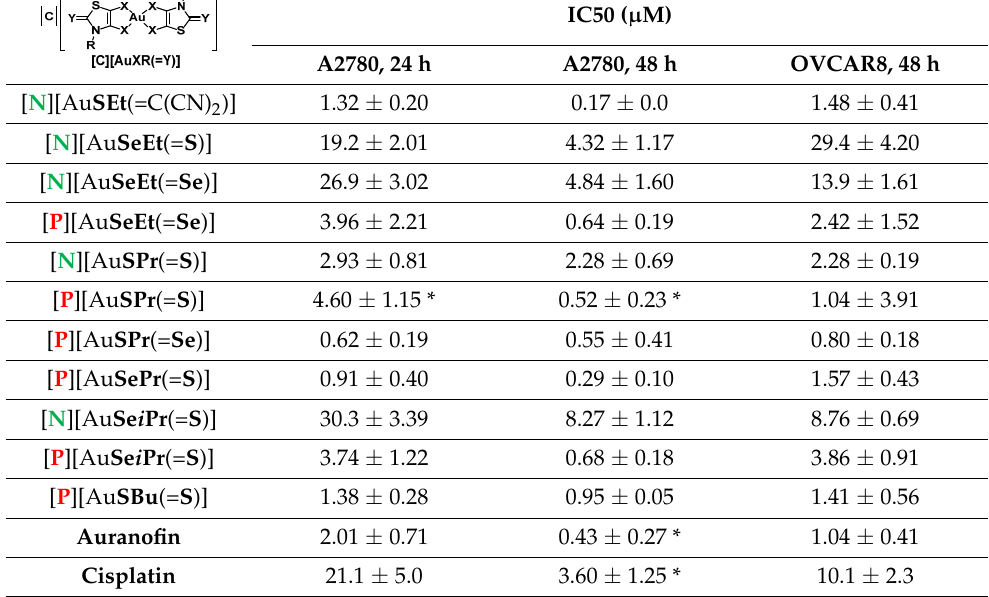
Table 2. IC 50 values (µM) calculated for the sixteen Au(III) bis(dithiolene/diselenolene) complexes and the reference drug Cisplatin and Auranofin on the ovarian cancer cells (A2780 and OVCAR8) Table 2. Cont. after 24 and/or 48 h